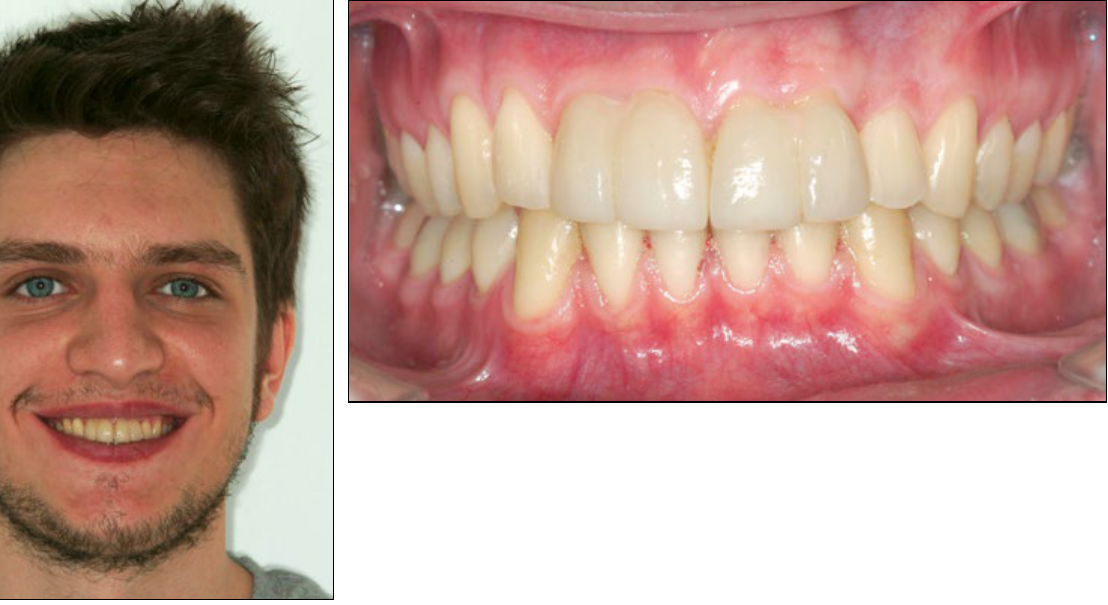
Figure 13, 14. Extra- and intraoral frontal photographs three years after the end of active orthodontic treatment. Alignment and PVLs remained